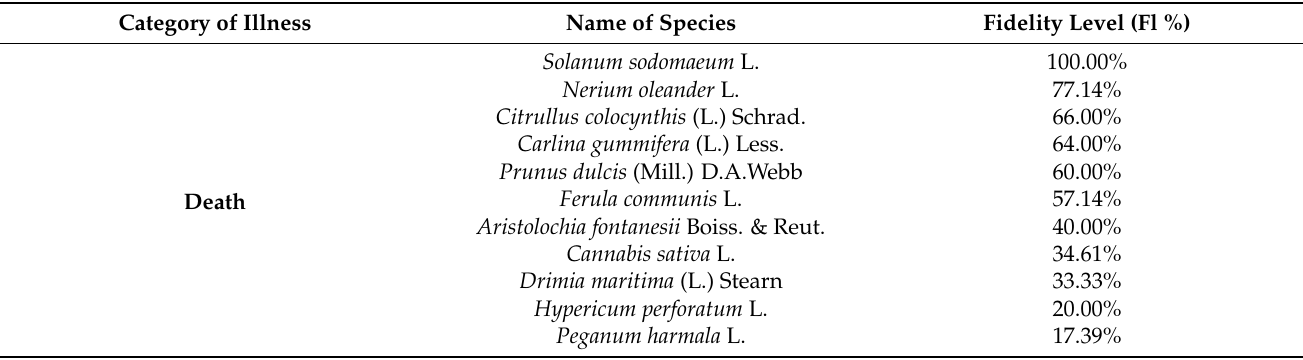
Table 4. The plants with fidelity level